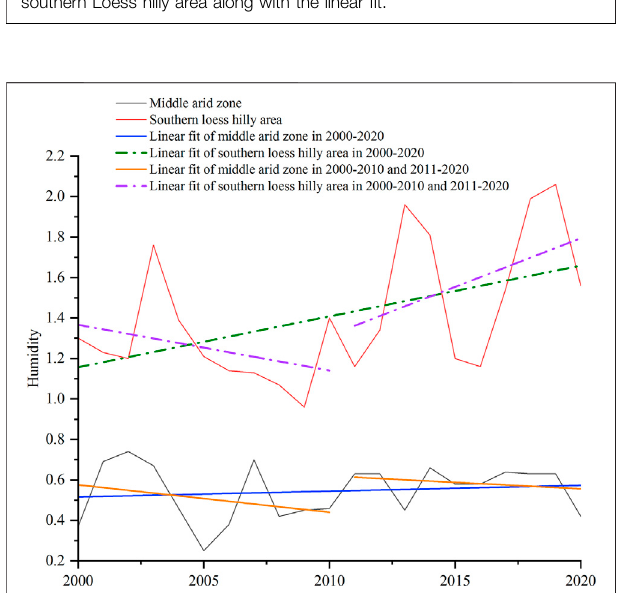
FIGURE 6 | Variation in humidity in the middle arid zone and southern Loess hilly area along with the linear fi t plots for 2000 – 2020, 2000 – 2010,